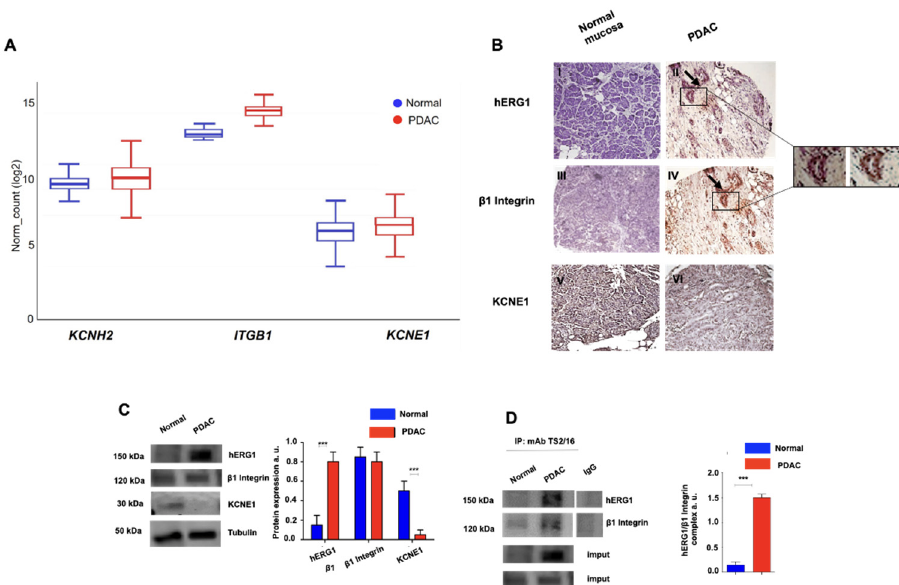
Figure 1. Gene expression profile and protein expression analysis of the hERG1/ β 1 integrin complex in pancreatic ductal adenocarcinoma samples. ( A ) Gene expression for KCNH2, ITGB1 and KCNE1 from TCGA/GTEx databases for PDAC and its normal counterpart. The final cohort featured 179 tumour samples from TCGA and 167 healthy samples from GTEx, for a total sample size of 346. The RNA-Seq expression data are given in units of log2 RSEM normalised counts. ( B ) Representative images of pancreatic samples. hERG1 in normal (I) and PDAC (II) samples (with representative insets), β 1 integrin in normal (III) and PDAC (IV) samples (with representative insets), and KCNE1 in normal (V) and PDAC (VI) samples. Arrows indicate the staining of the same cells. IHC experiments and scoring assessment were performed as described in Materials and Methods. Scale bar: 200 µm. ( C ) hERG1, β 1 integrin and KCNE1 protein expression (reported as normalized bands intensity; n = 3) in normal and PDAC samples. Representative blots of protein expression evolution (left panel) and densiometric analysis (right panel) are reported ( n = 3). ( D ) Representative blots and corresponding densitometric analysis of the co-immunoprecipitation between hERG1 and β 1 integrin (performed using TS2/16) in normal and PDAC samples. Data are presented as mean values ± s.e.m. *** p <